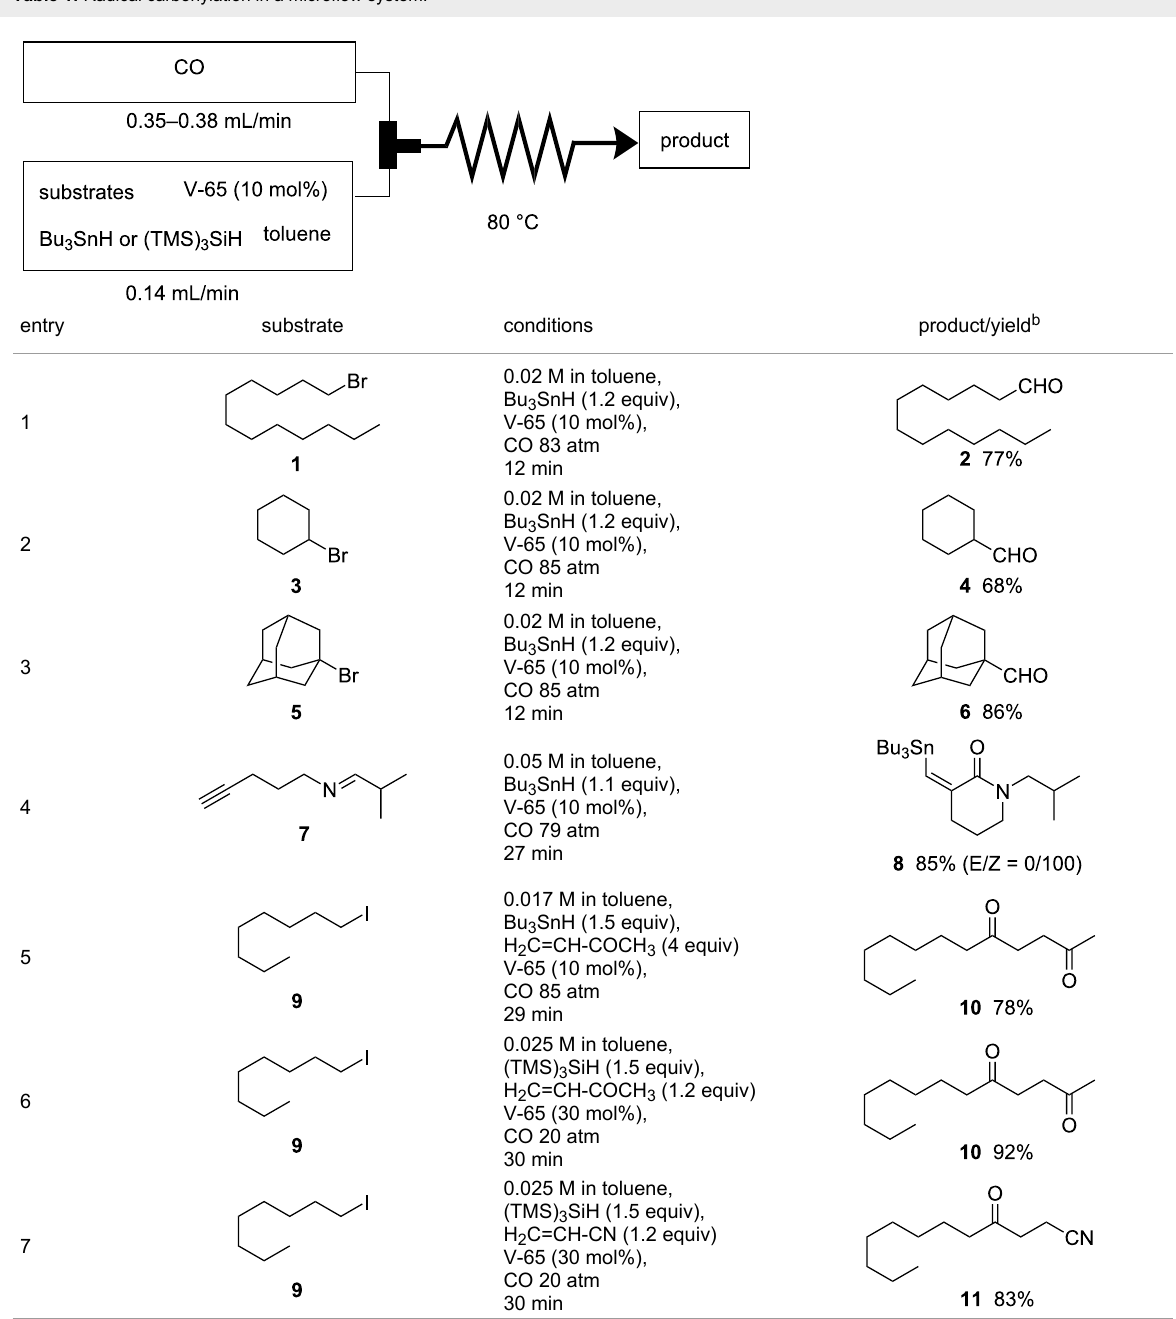
Table 1: Radical carbonylation in a microflow system.